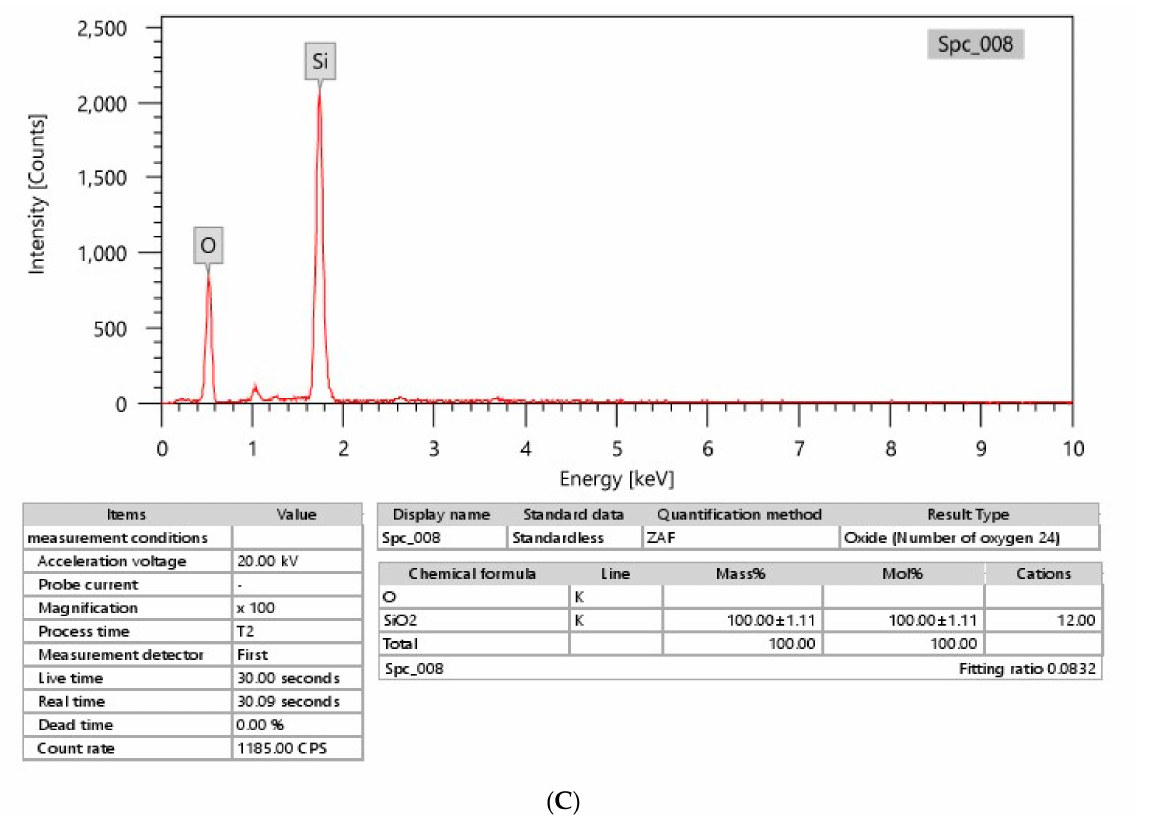
Figure 1. Characterization of the silicon dioxide nanoparticles (SiO 2 NPs) used in the current paper. ( A ) TEM image with an average size of 110.20 ± 3.28 nm. ( B ) The zeta potential and ( C ) the composition analysis (EDX) of the constituents, showing the presence of silicon and oxygen elements.